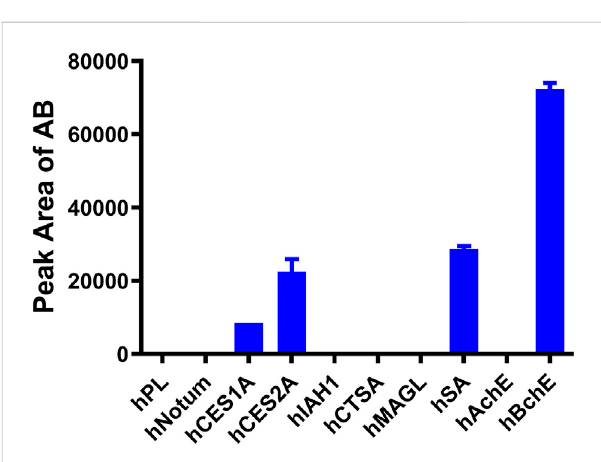
Reaction phenotyping assays of AB23A hydrolysis: AB23A (20 μ M) was incubated with each tested human hydrolase for 60 min under physiological conditions (pH 7.4 at 37 ° C). The protein concentration of hPL, hNotum, hCES1A, hCES2A, hIAH1, hCTSA, hMAGL, hAchE, and hBchE in the reaction system were 5 μ g/mL, the hSA was 500 μ